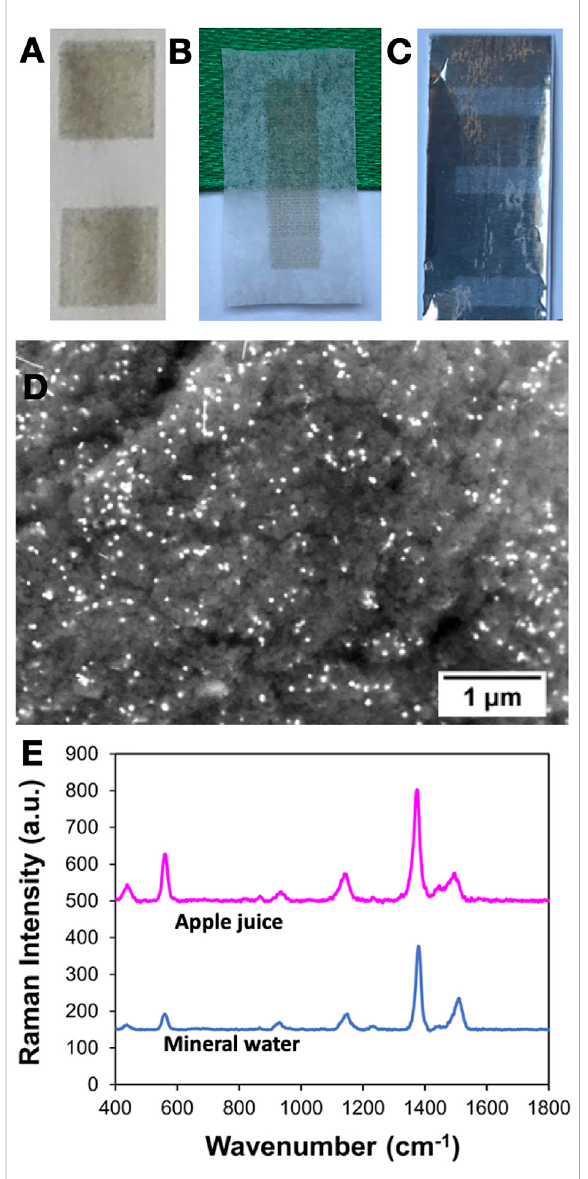
FIGURE 8 SERS substrates prepared by inkjet printing of metal colloids on different types of paper: (A) Ag/PS on of fi ce paper; (B) Ag on parchment paper (C) Au/PS on aluminium foil paper; (D) SEM image of of fi ce paper printed with Ag/PS ink, showing the metal NPs as white spots on a polymeric background.; (E) SERS spectra of thiram (10 − 6 M) spiked in apple juice and mineral water using Ag/PS as the substrate.